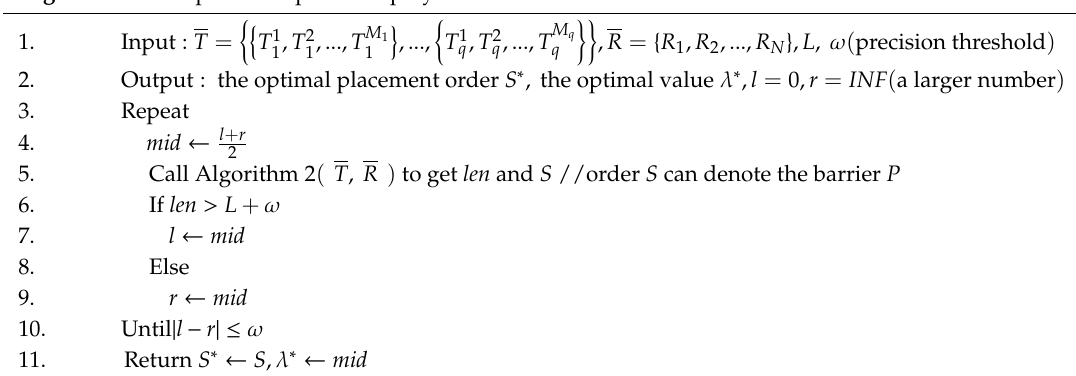
Algorithm 1 Compute the optimal deployment for Problem